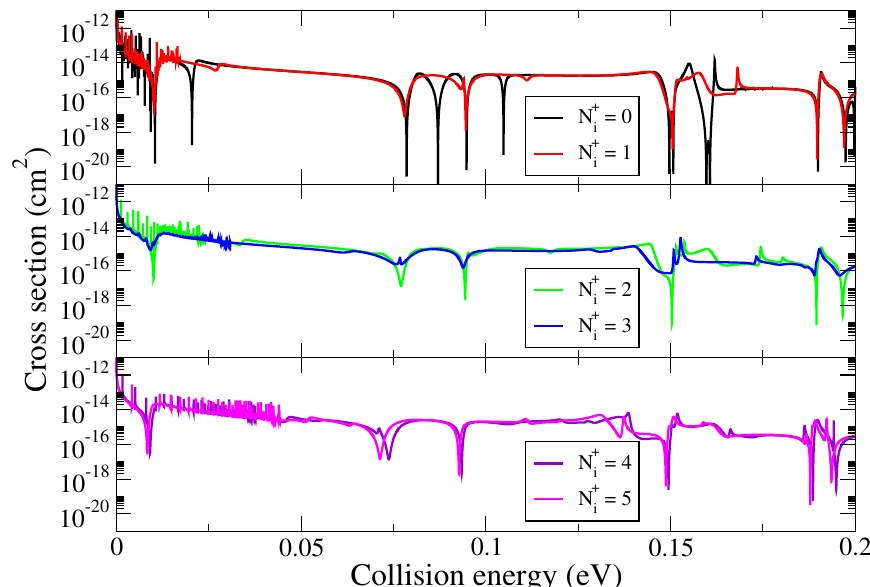
Figure 3. Cross sections for the dissociative recombination of vibrationally relaxed CH + ( X 1 Σ + ) on = 0 to 5 for electron collision energy in the range 0 − 200 meV. initial rotational levels N + i